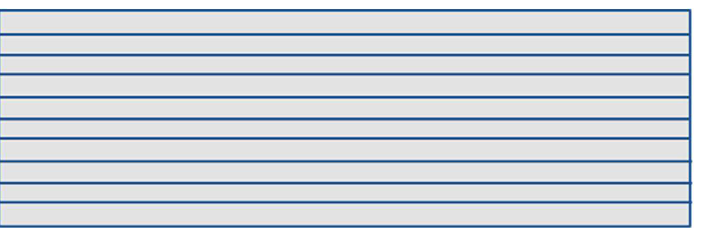
Figure 2. Image of the large area samples obtained drawing lines with distance of 0.1 mm. The size of the large area sample was within a few cm 2 , i.e., 25 mm × 10 mm.